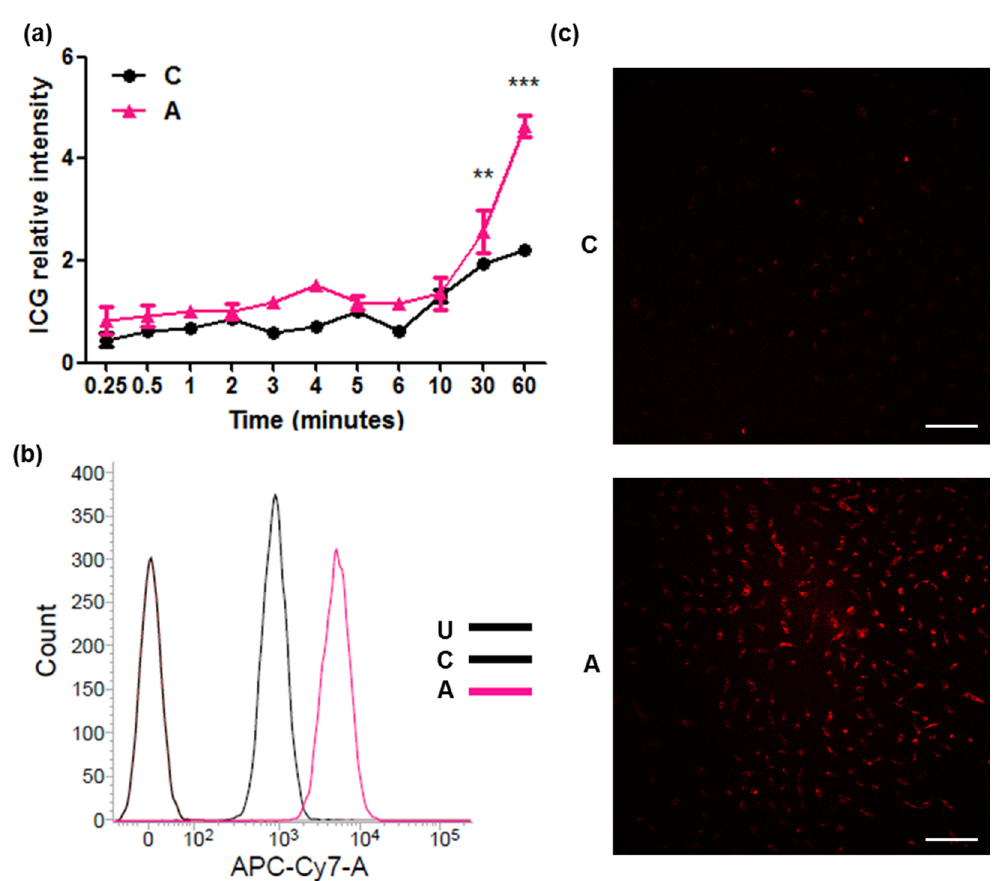
Figure 2. Indocyanine green (ICG) intake through ASBT. ( a ) The ICG intensity of treatment for different periods. ( b ) The ICG intensity detected through flow cytometry. ( c ) The ICG intensity visualized using confocal microscopy. C: control cells. A: cells expressing ASBT. U: untreated. Scale bar: 100 μ m. Error bars show the SEM, where ** p < 0.01 and *** p < 0.001.